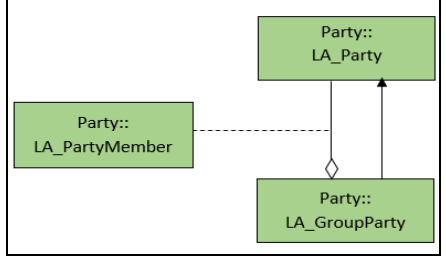
Figure 3. Classes of Party Package